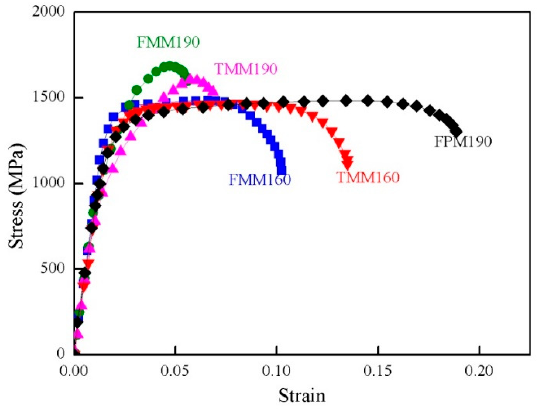
Figure 8. Engineering stress–strain curves of three different matrixes after the Q&P process.